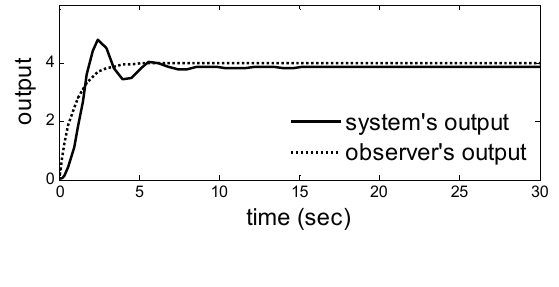
Figure 2. The outputs when a = − 1 and b =